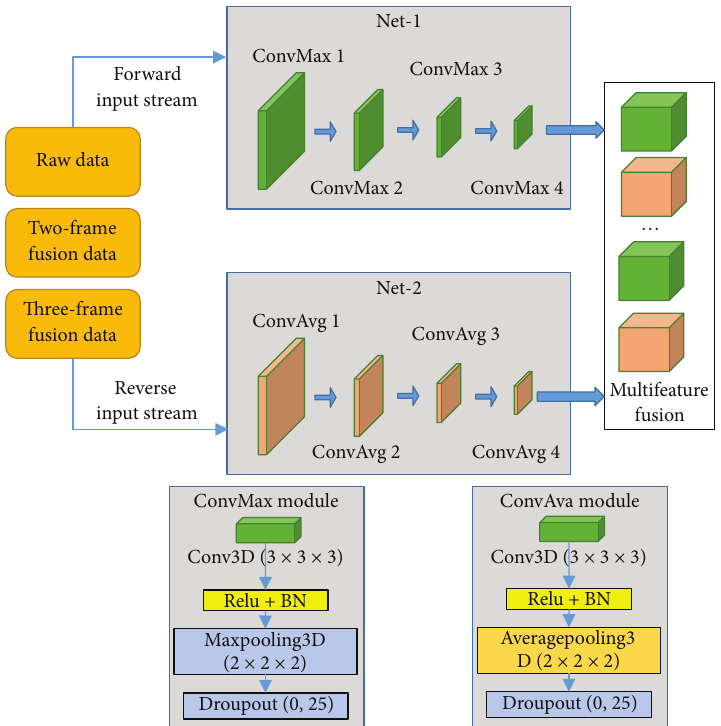
Figure 2: Two-way feature extraction